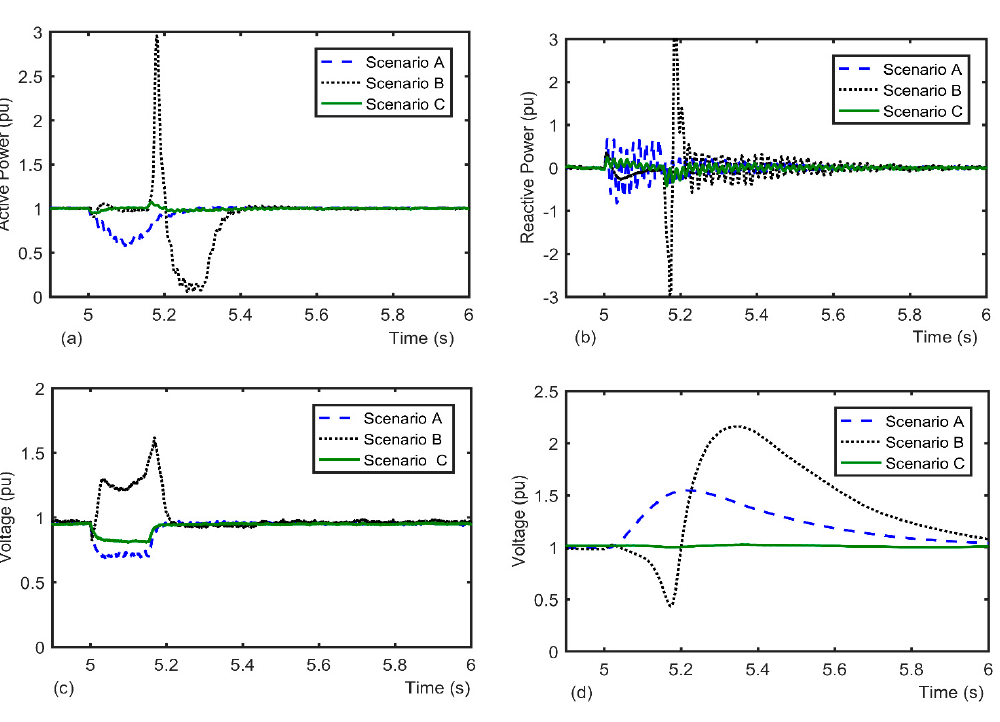
Figure 5. Low voltage sag, ( a ) Active power, ( b ) Reactive power, ( c ) Terminal voltage ( d ) DC link voltage.